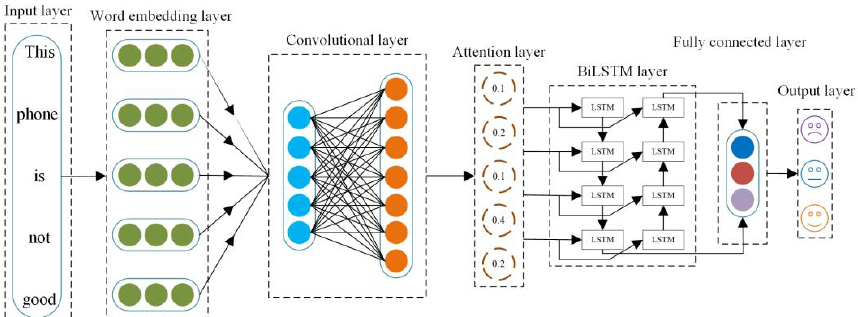
Figure 4. Structure of the AB-CNN model.